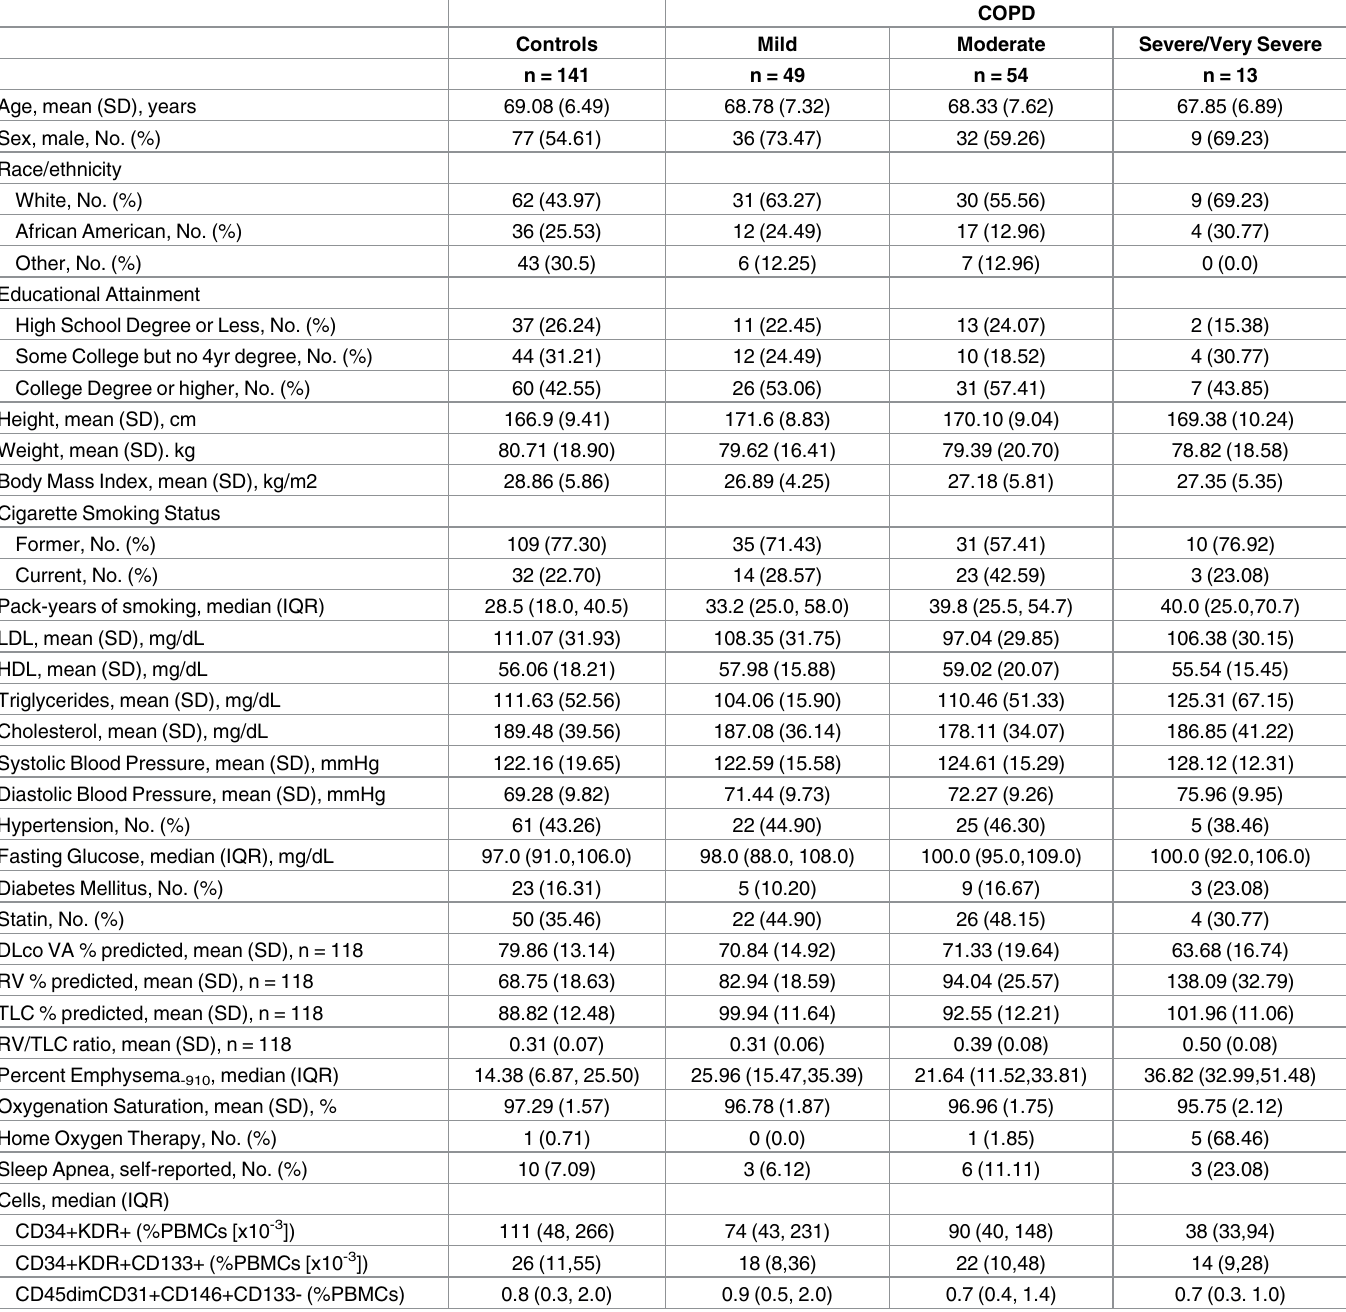
Table 1. Clinical characteristics of participants in the MESA COPD Study with measuresof endothelial progenitor cells, stratified by COPD